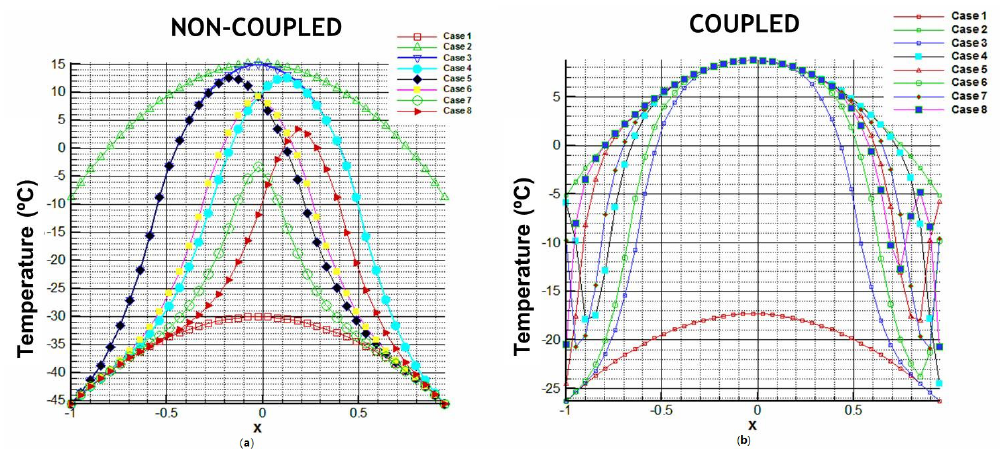
Figure 13. Several stationary solutions for Q = 250 obtained for the EBM ( a ) and Coupled model ( b